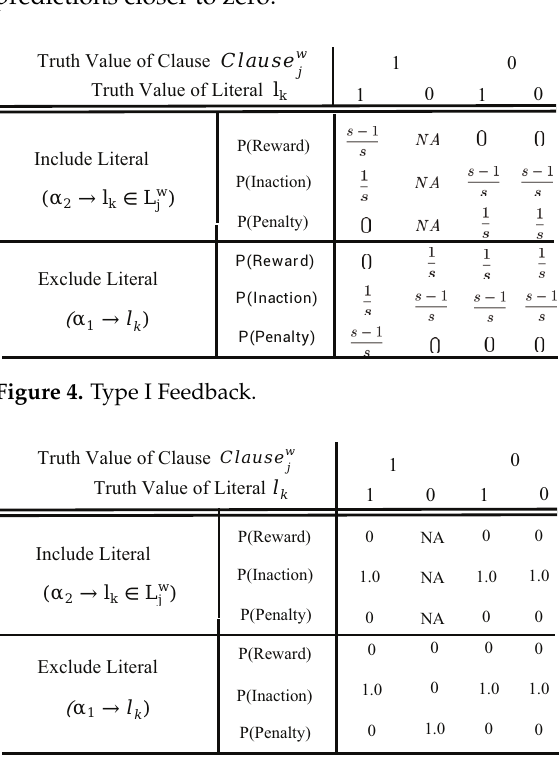
Figure 5. Type II